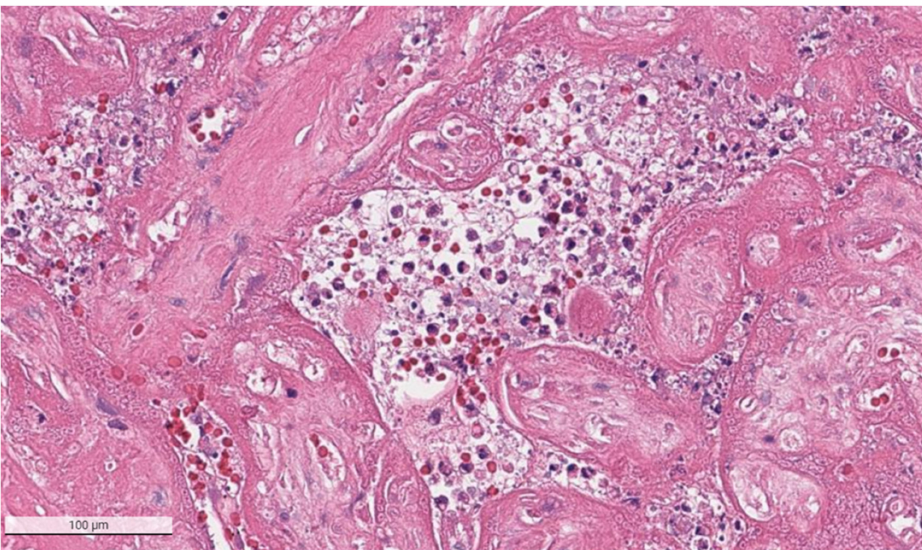
Figure 4. Chronic histiocytic intervillositis is present demonstrating histiocytes within the remnants of the intervillous spaces in a placenta with massive perivillous fibrin deposition and trophoblast necro- sis. This stillborn fetus was delivered to a mother with COVID-19. The syncytiotrophoblast of this placenta was strongly positive for SARS-CoV-2 antigens using immunohistochemistry. Hematoxylin & eosin staining, ×